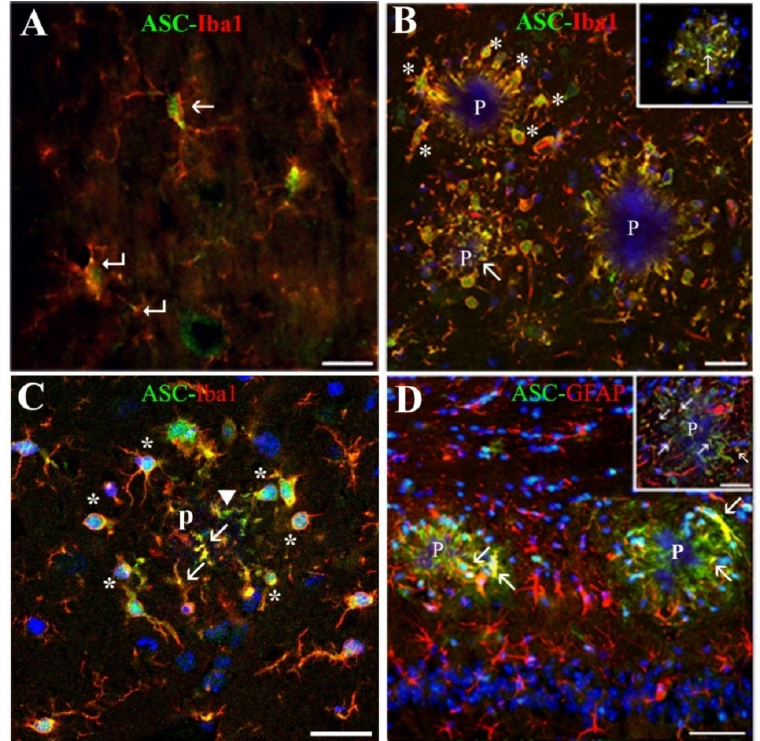
Figure 2. ASC is associated with microglial and astroglial cells soma and processes inside and around plaques. ( B , C ) and insets in ( B , D ) are confocal images. ( A ) Shows that in WT HP, ASC is mainly located in microglial nuclei (arrow) and in dispersed small spots along their processes (bent arrows), whereas in APP/P HP shown in ( B , C ), ASC is present, not only in microglial nuclei (asterisks) but more abundantly in processes penetrating plaques (p) (arrows in ( B , C ). Note that some ASC inside the plaques does not co-label with Iba1 (arrow in ( B ) inset, and arrowhead in ( C )), and that microglial nuclei are white due to co-labeling of ASC and Hoechst. ( D ) Shows that some ASC associated to plaques (p) co-label with astrocytic GFAP (arrows), in soma, processes, and, as shown in ( D ) inset, also in process terminals (arrows) inside the plaque. Scale bars represent 20 µ m in ( A ), 50 µ m in ( B ) and insets, and 25 µ m in ( C , D